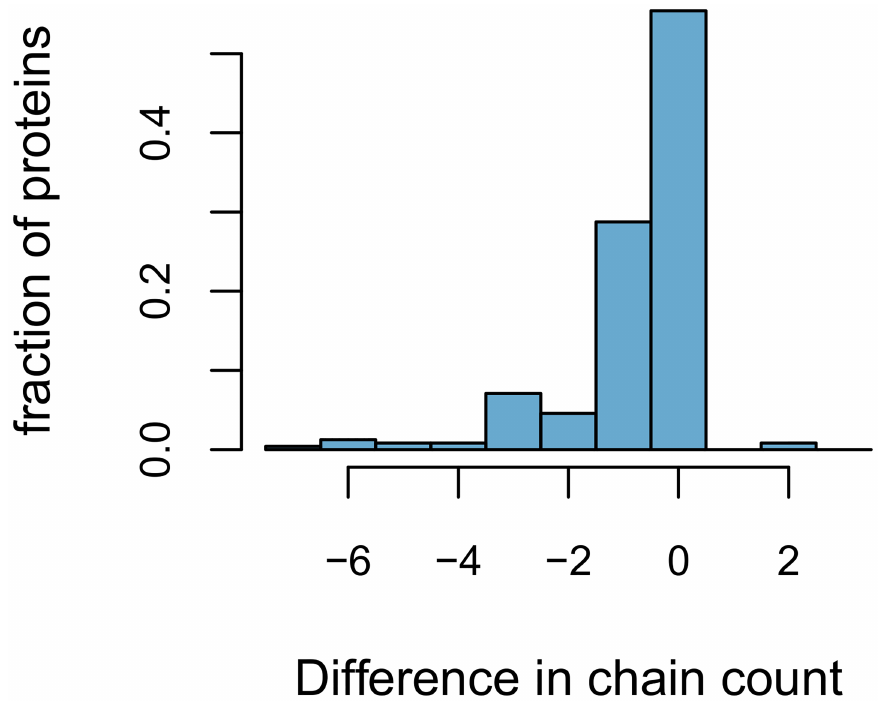
Fig 11. Differences in number of polypeptide chains between the protein models present in the dataset ‘Peripheral’ (quaternary structure model from OPM) and the models in ‘Peripheral-P’ (quaternary structure model predicted by PISA). The difference is calculated for each of the PDB IDs occurring in both datasets. When more chains are present in the PISA models, The difference (horizontal axis) is negative.